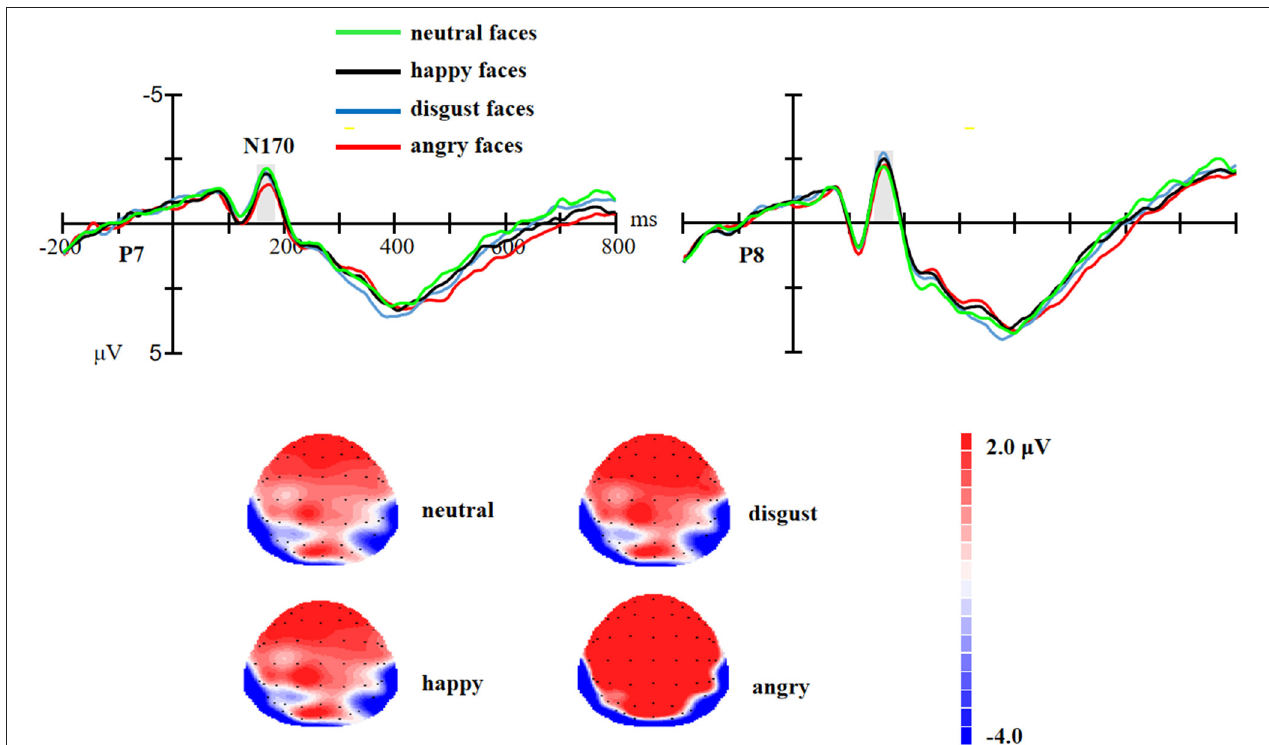
FIGURE 2 | Upper: The event-related potential (ERP) waveforms for angry, disgust, happy, and neutral facial expressions at P7 and P8 electrode sites. Bottom: The scalp distribution of the mean N170 amplitude (150–180ms) for angry, disgust, happy, and neutral facial expressions. 1 RT/accuracy and 1 ERP amplitude by emotional facial expressions (angry, disgust, and happy) were examined by using the Pearson correlation analyses. To control for the multiple comparisons problem, the corrected p- value was set at